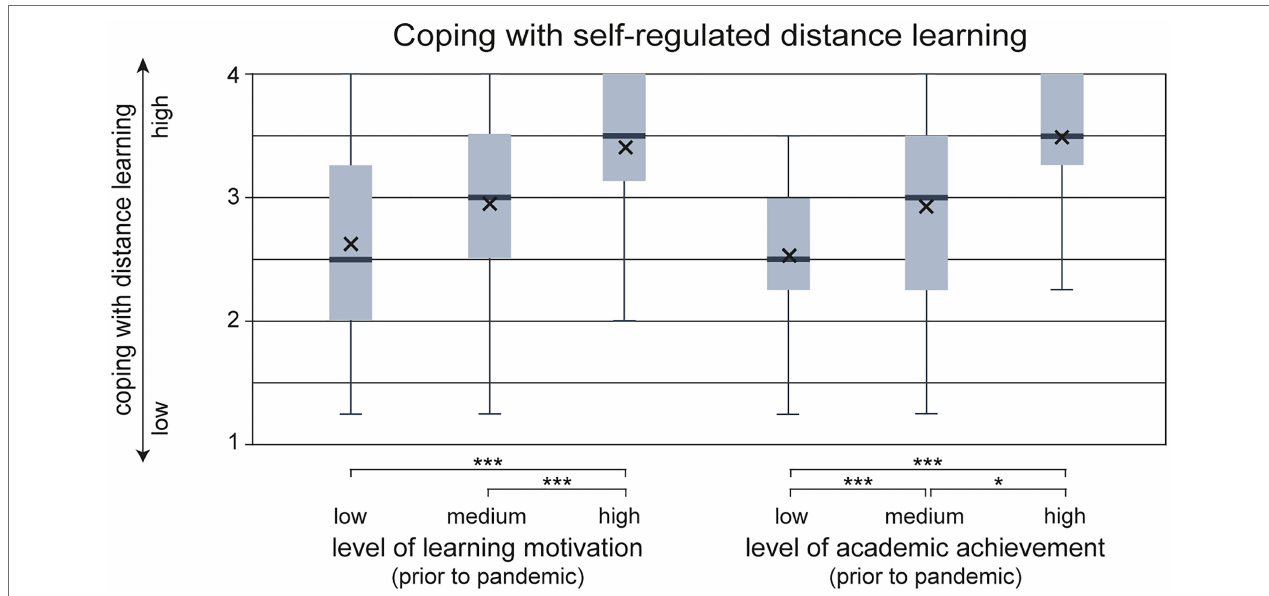
FIGURE 1 | Coping with self-regulated distance learning depending on learning motivation and academic achievement prior to pandemic. Box-and-whisker plots showing the distribution of coping with self-regulated distance learning for three groups each depending on the students’ learning motivation and academic achievement prior to the pandemic. Additionally, group mean scores are shown in the form of an x. Significant differences between groups are highlighted below the diagram (* p < 0.05 and *** p < 0.001).